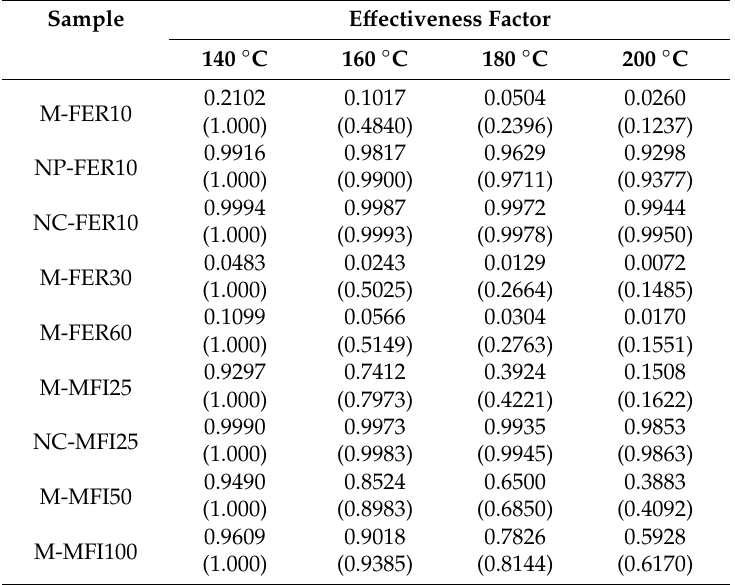
Table 5. E ff ectiveness factor at di ff erent reaction temperatures. The normalised e ff ectiveness factor with regard to the value obtained at 140 ◦ C is reported in